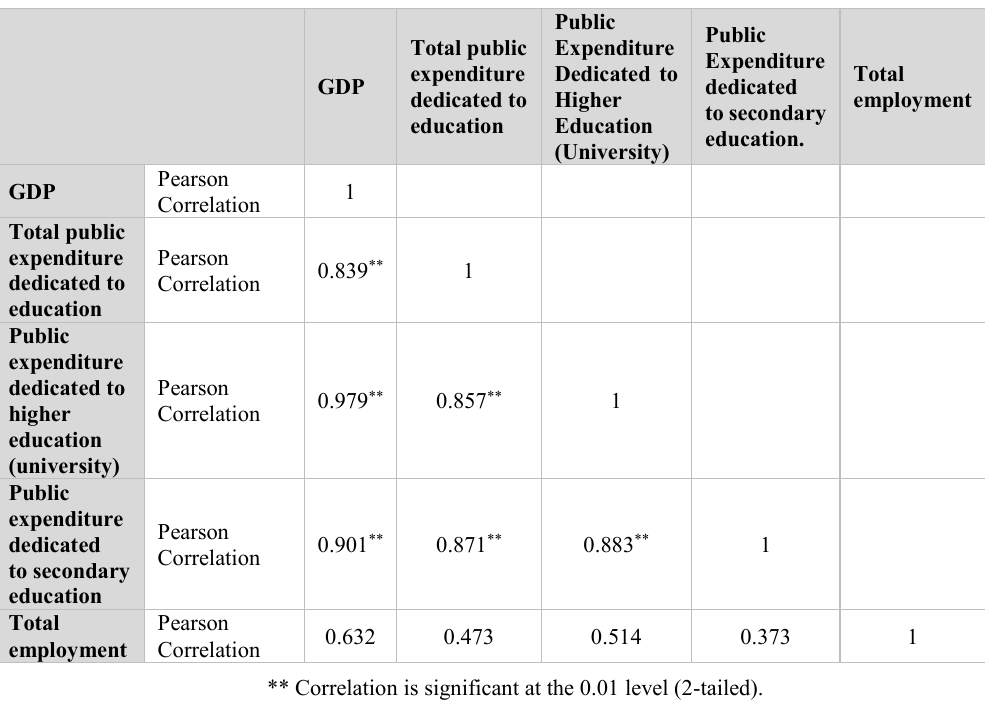
Table 1. Pearson Correlation